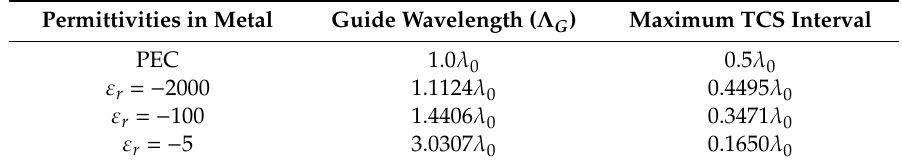
Table 1. Guide wavelengths with respect to metallic permittivities and computed maximum TCS intervals.